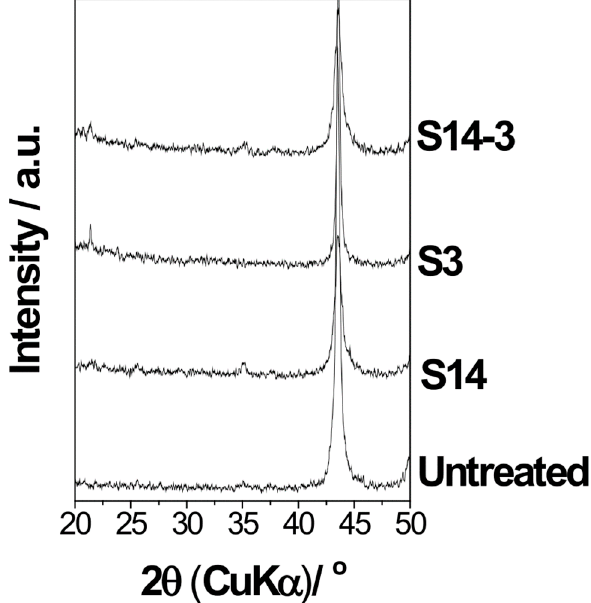
Figure 7. XRD patterns of the surface of S14, S3 and S14-3 after the ‘Basic SBF’ treatment and the untreated SUS316L plate.